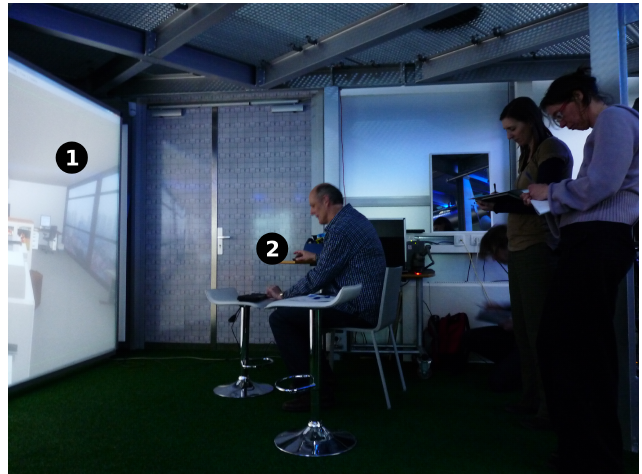
Fig. 4. The two application prototypes and their levels of realism.